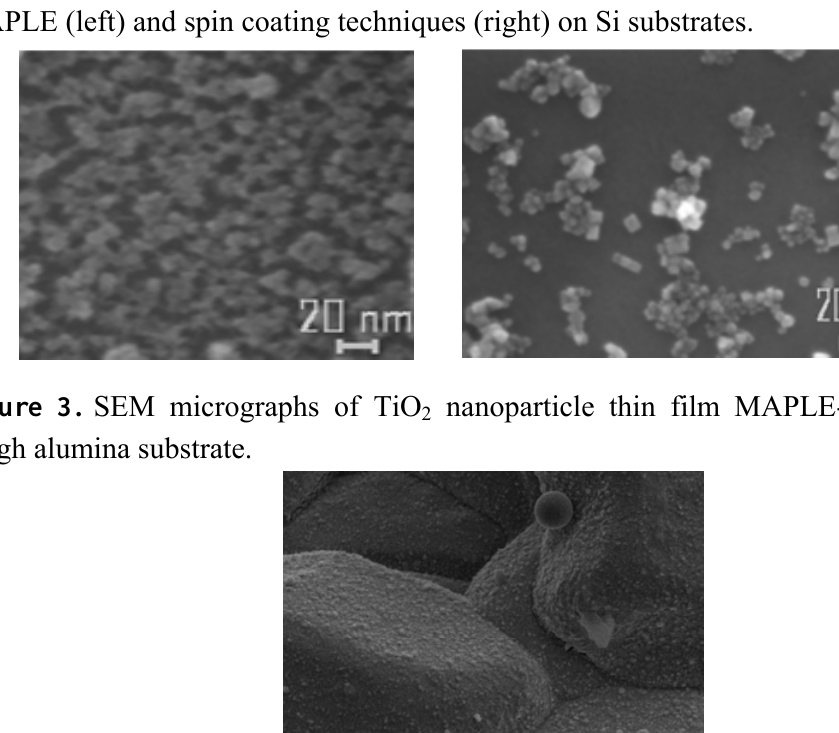
Figure 2. High resolution SEM micrographs of TiO MAPLE (left) and spin coating techniques (right) on Si substrates.